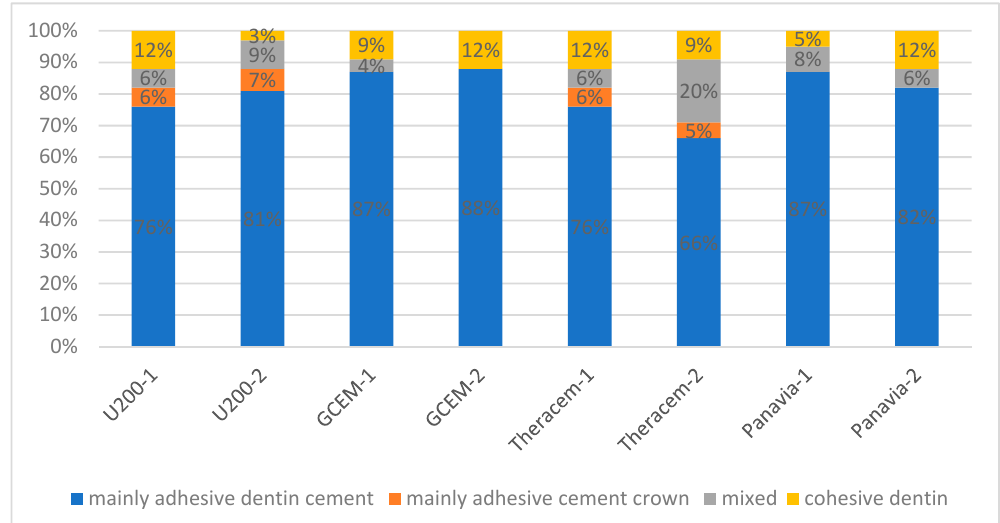
Figure 3. Distribution of failure modes (percentage of surfaces) for each SARC in the non-aged (1) and aged (2) groups.